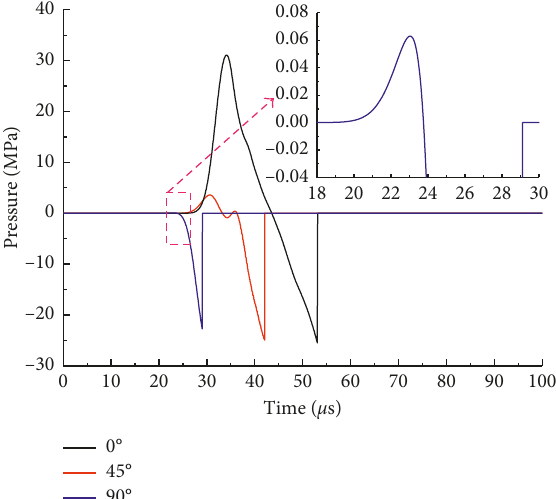
Figure 14: Relationship between peak pressure and fillings.